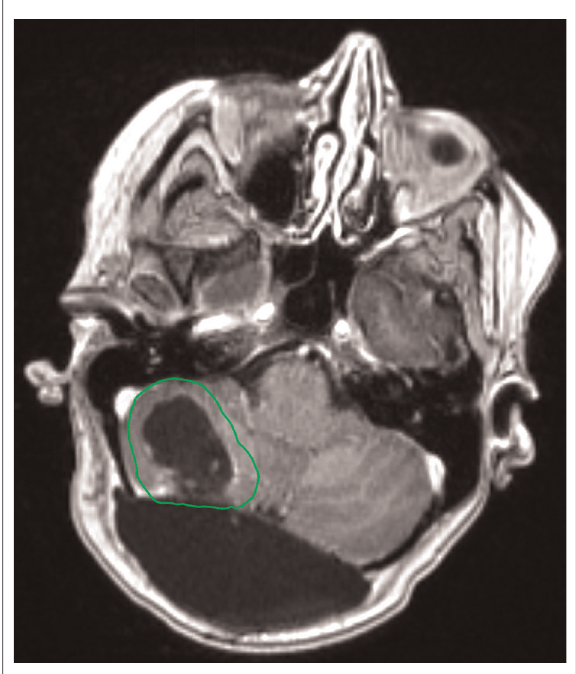
FIGURE 1 Radiation treatment plan of a 65 year old female patient with a history of breast cancer. She underwent a surgical resection followed by postoperative SRS to the resection cavity (outlined in green) to a dose of 27 Gy in 3